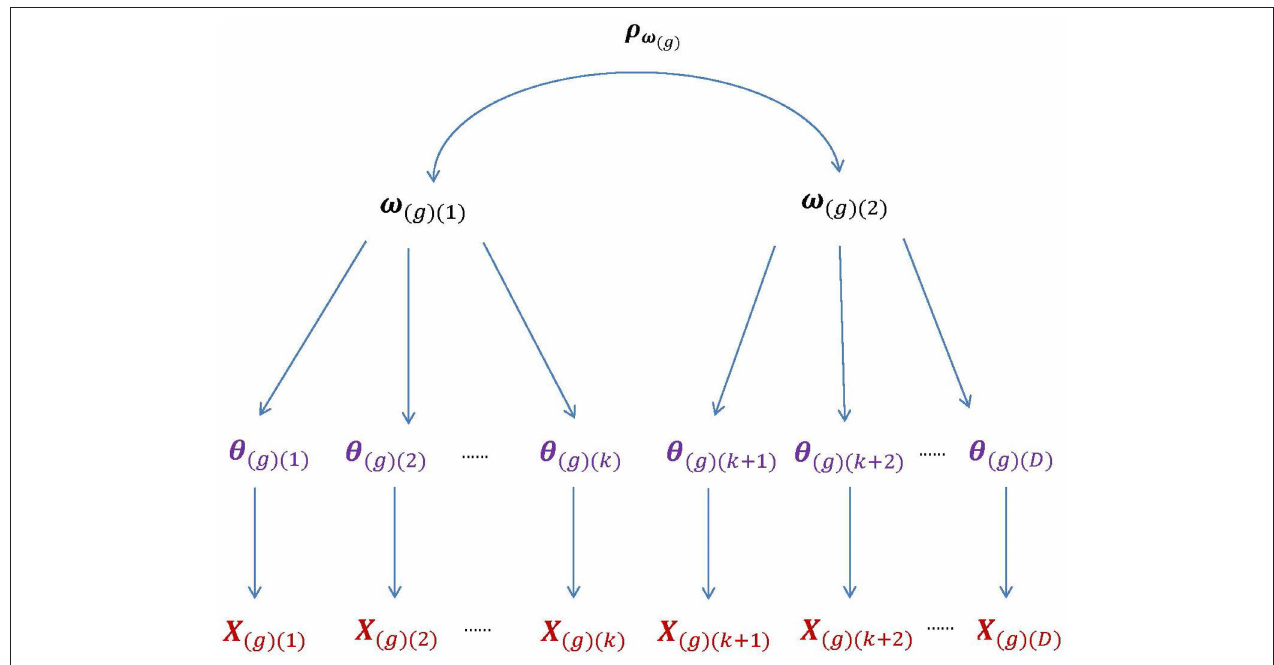
FIGURE 1 | The higher-order structure of the bivariate HO-IRT model for multiple groups. The second-order latent trait for group g , ω ( g ) , is bivariate with the correlation matrix ρ ω , whereas the first-order latent trait, θ ( g ) , is D -dimensional. The first higher-order component, ω ( g )(1) , are related to the first k components (i.e., (g) dimensions) of θ , whereas the second higher-order component, ω ( g )(2) , to the remaining ( D − k ) components. Further, the components of the first-order trait θ ( g ) are assumed to be independent conditional on the second-order traits ω ( g )